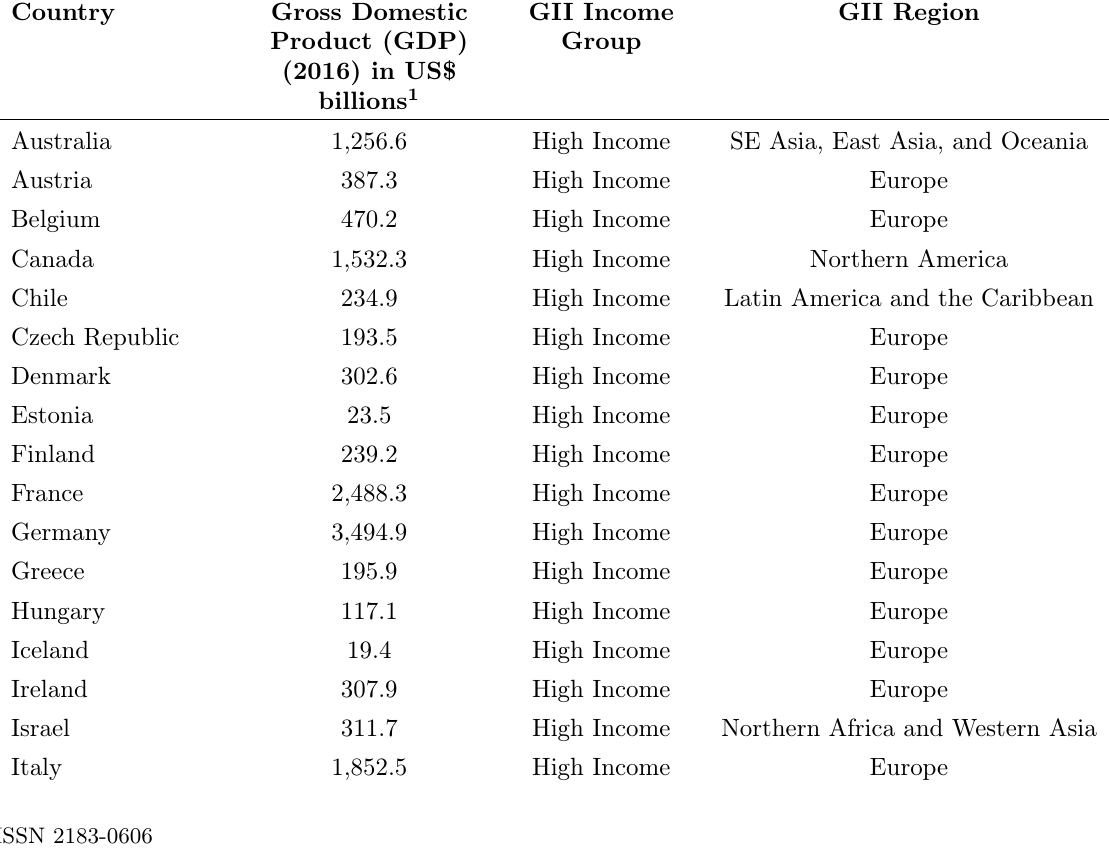
Table 1. OECD sample